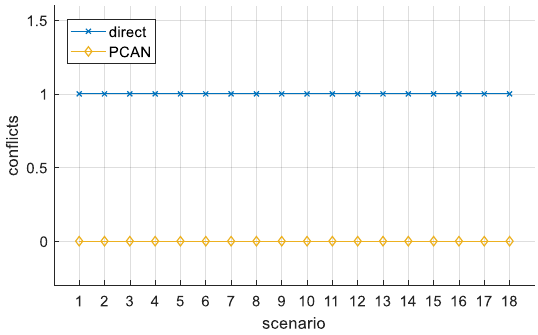
Figure 7. Two-UAV study. The number of conflicts.